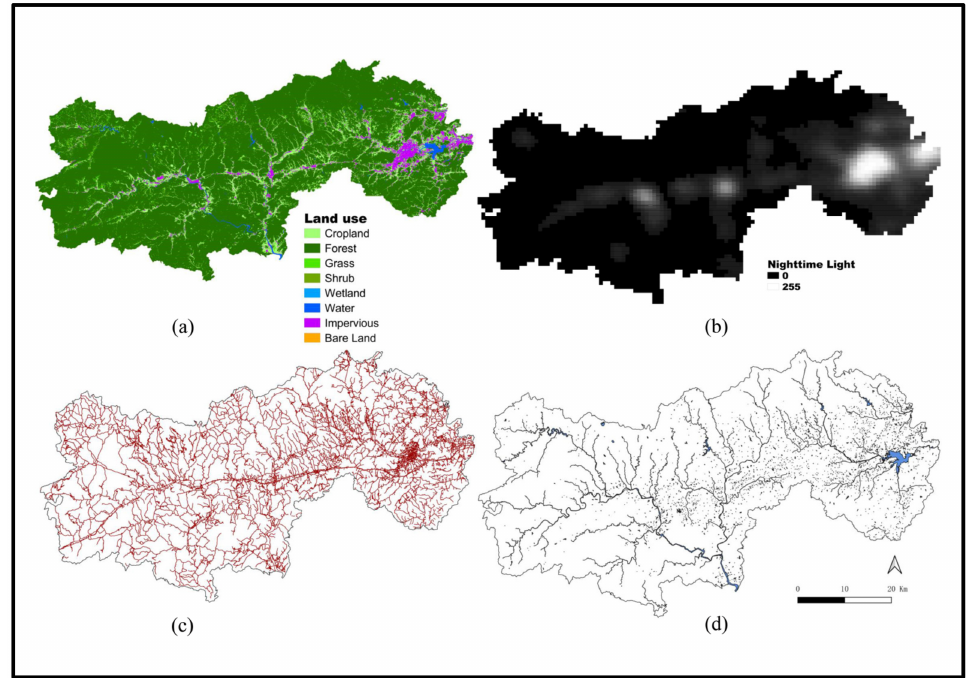
Figure 3. ( a ) Land use data, ( b ) NTL data, ( c ) road system data, and ( d ) water system